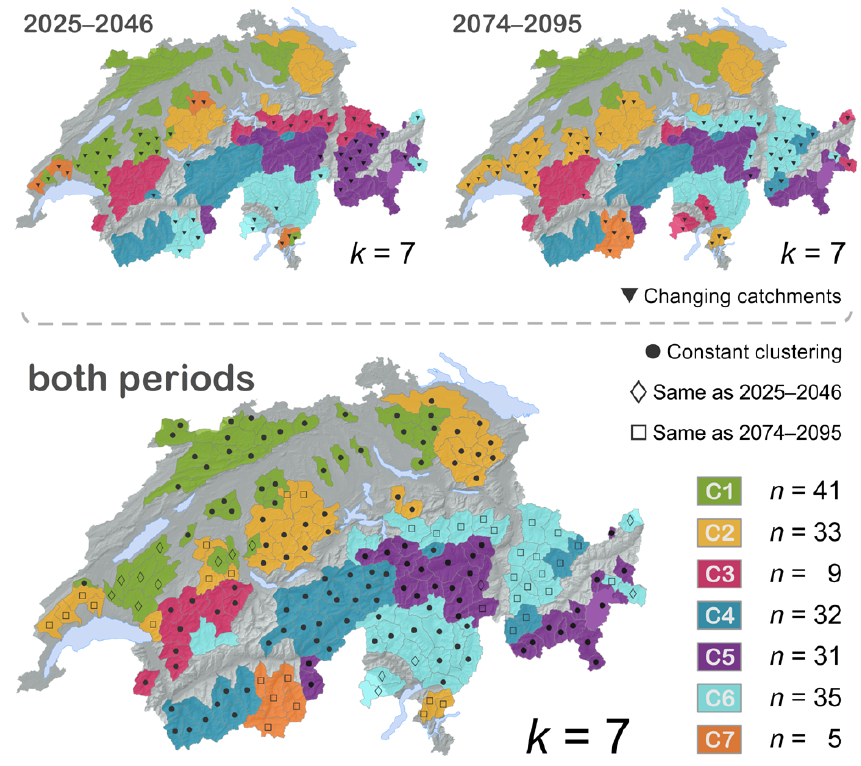
Fig. 3. Cluster analysis for hydro-climatological change signals of the near future (2025–2046, upper left panel), the far future (2074–2095, upper right panel) and both periods in combination (lower panel). The number of cluster members n is given for every cluster. The catchments that are assigned to the same cluster in all three versions are marked with a solid circle in the lower panel.